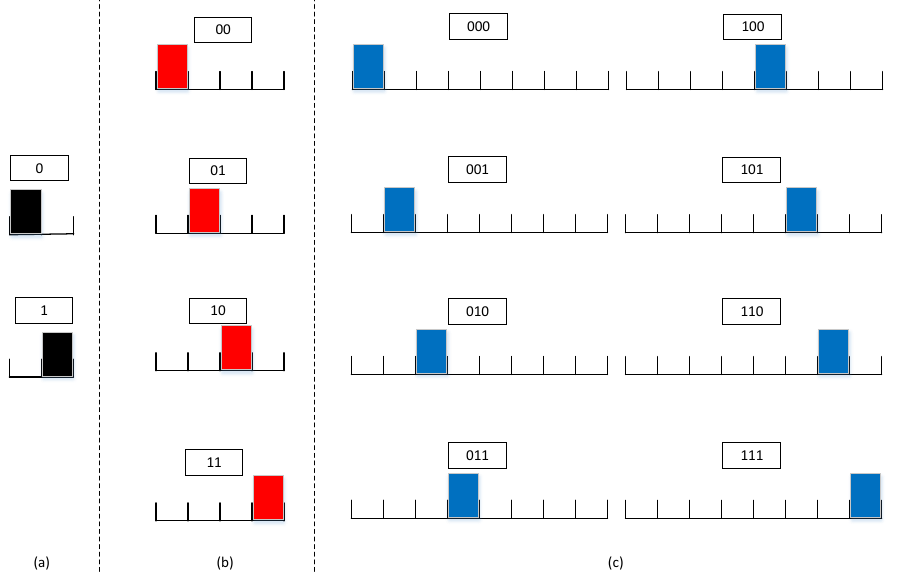
Figure 1. Q -ary PPM signal. ( a ) is a binary PPM, ( b ) is a 4-ary PPM and ( c ) is a 8-ary